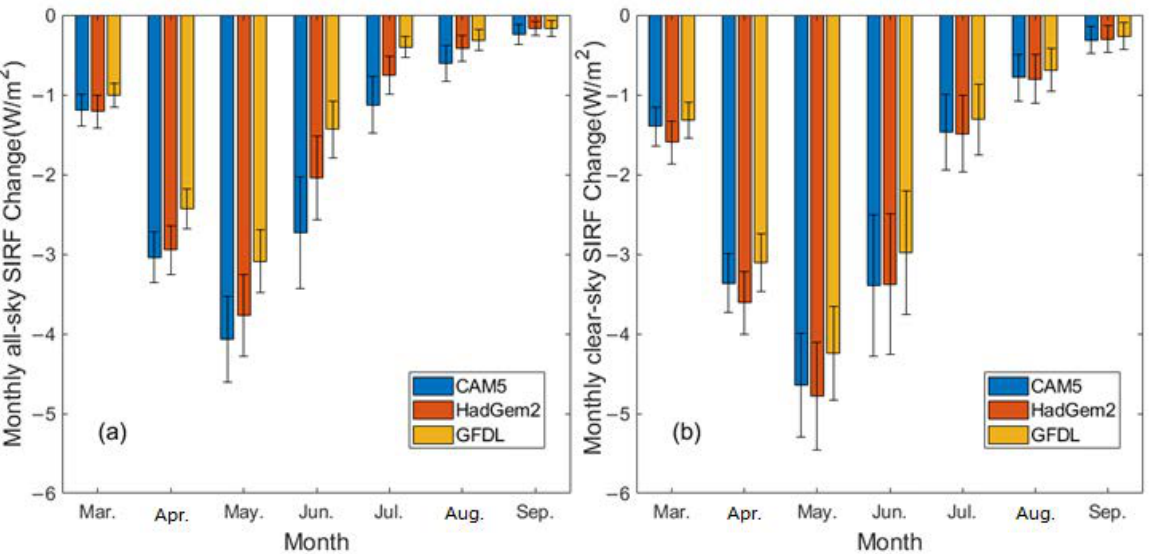
Figure 4. Month-scale variation in mean SIRF from March to September of ( a ) all-sky and ( b ) clear-sky. The vertical black line is the fluctuation